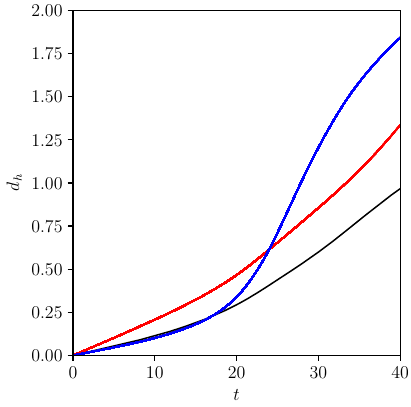
Figure 8. Case 2.1: effect of doubling the vertical offset between the two vortices of the heton. Top view of the flow showing contours of buoyancy and PV at t = 14, 20, 26 and 40 from ( a ) to ( d ).